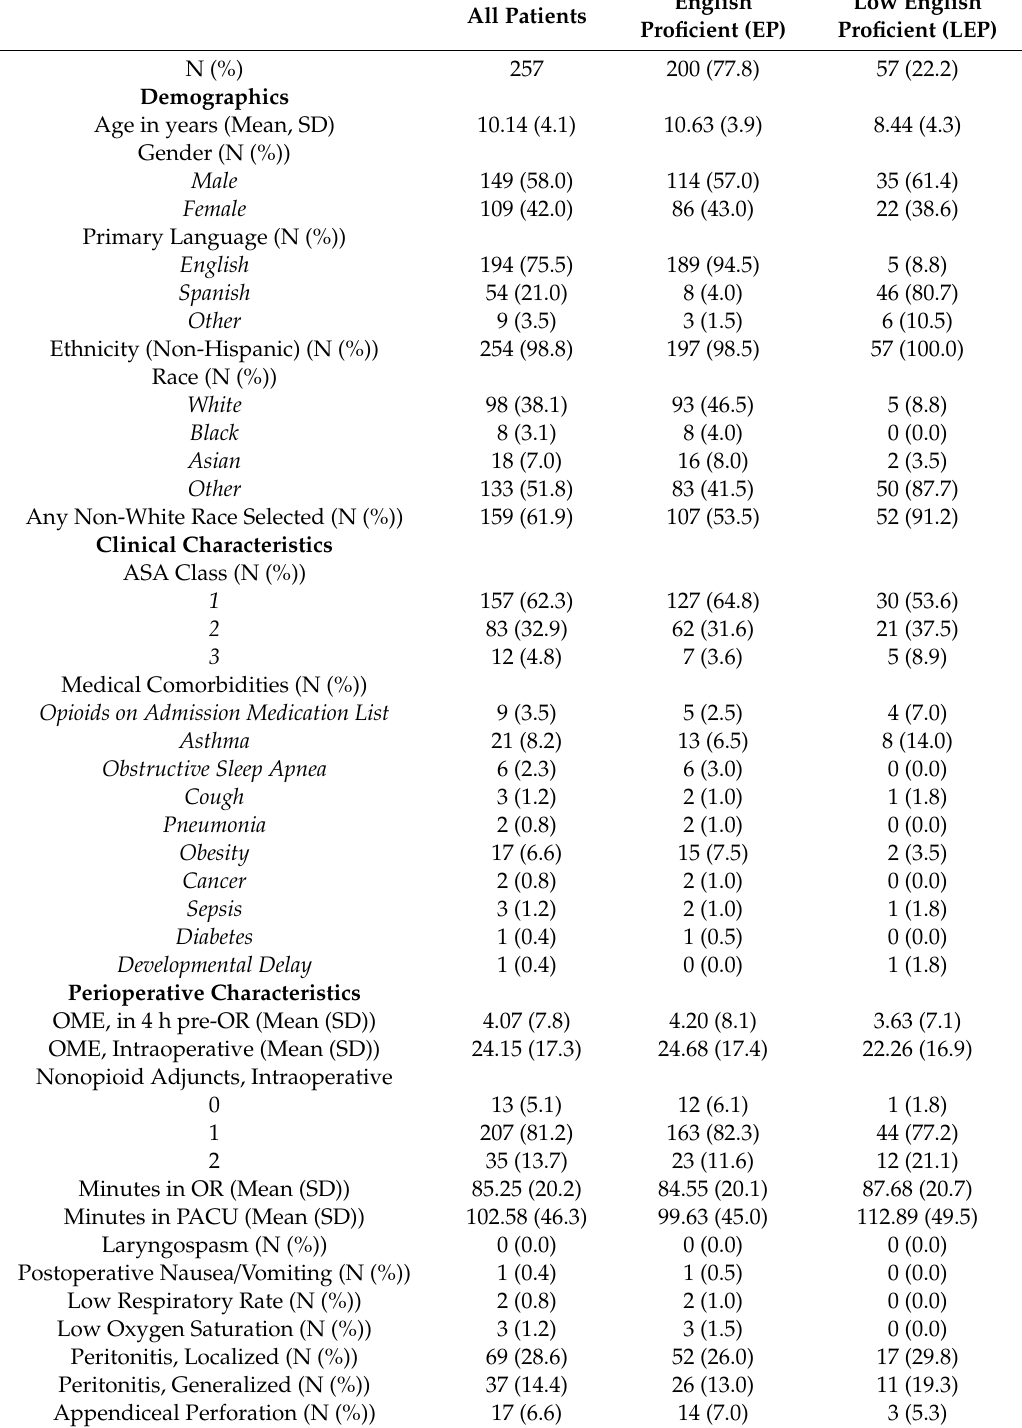
Table 1. Characteristics of the study